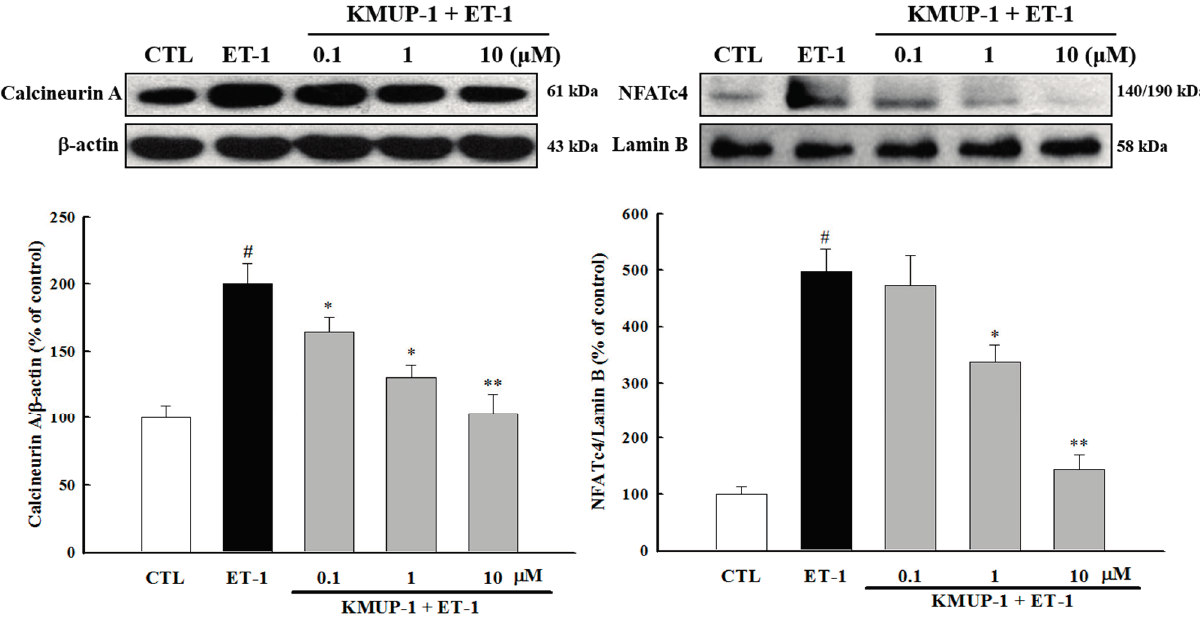
Figure 5. Effects of KMUP-1 on calcineurin-NFATc4 signaling. H9c2 cells were